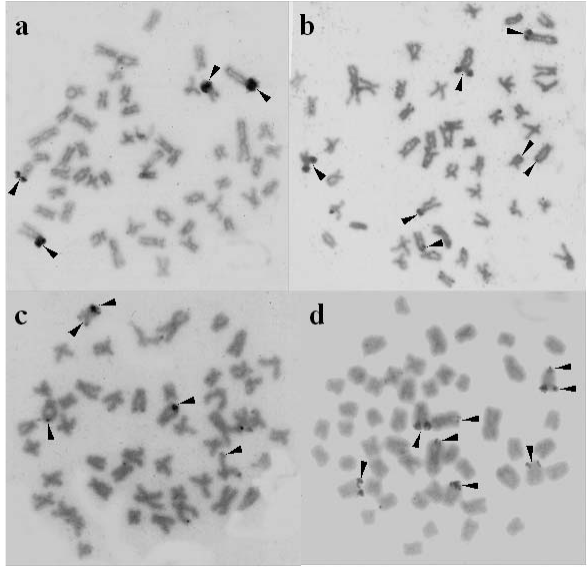
Figure 3 - Chromosome metaphase spreads of Triportheus venezuelensis . FISH probed with 18S rDNA. The original colors were artificially trans- formed. Arrows indicate the detected